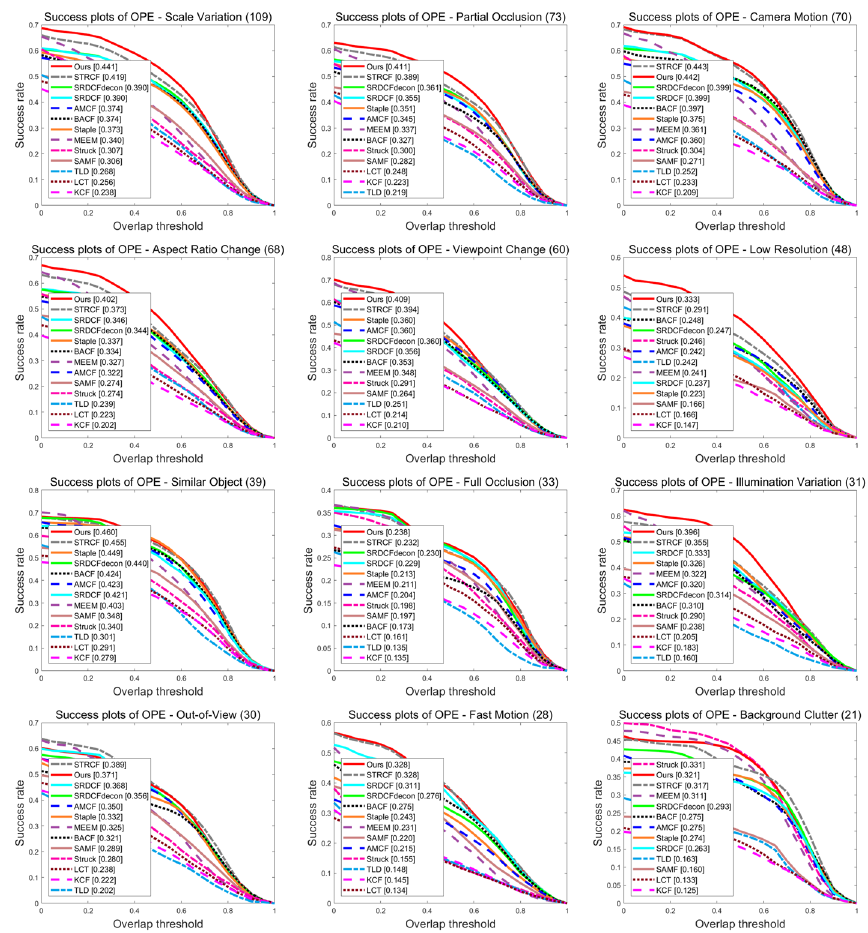
Fig. 7 Success plots of different attributes of all trackers on 123 UAV sequences